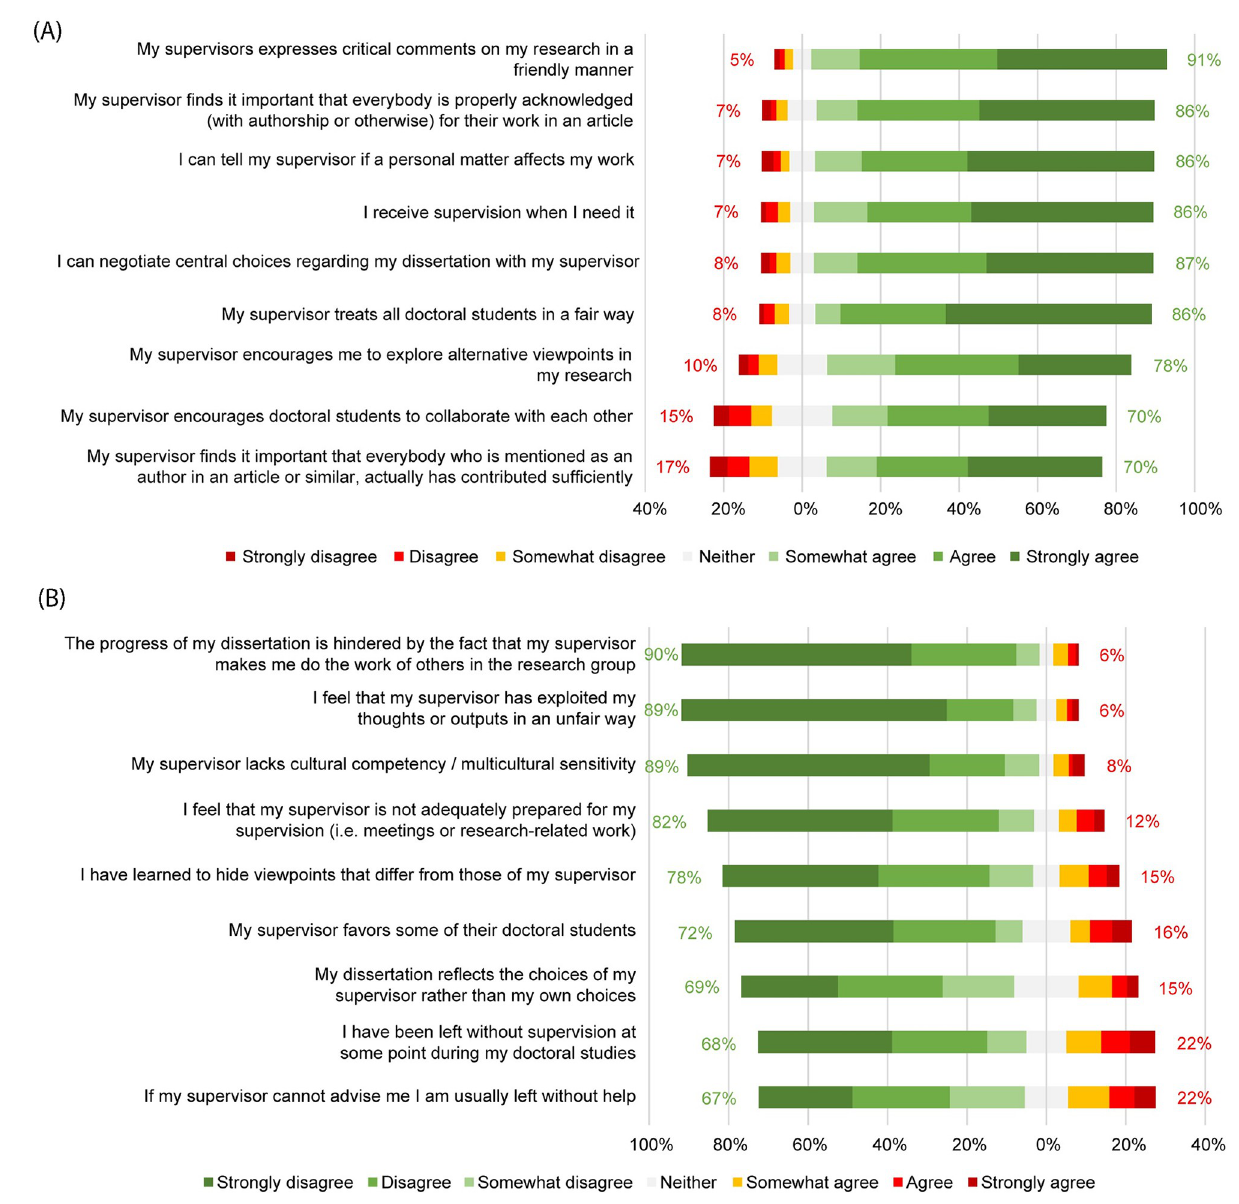
Fig 4. PhD candidates’ characterization of their primary supervisor’s